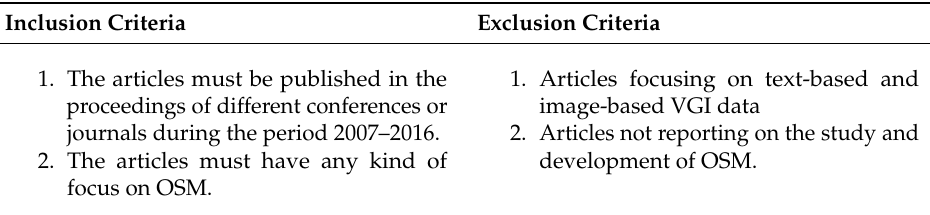
Table 1. Inclusion and exclusion